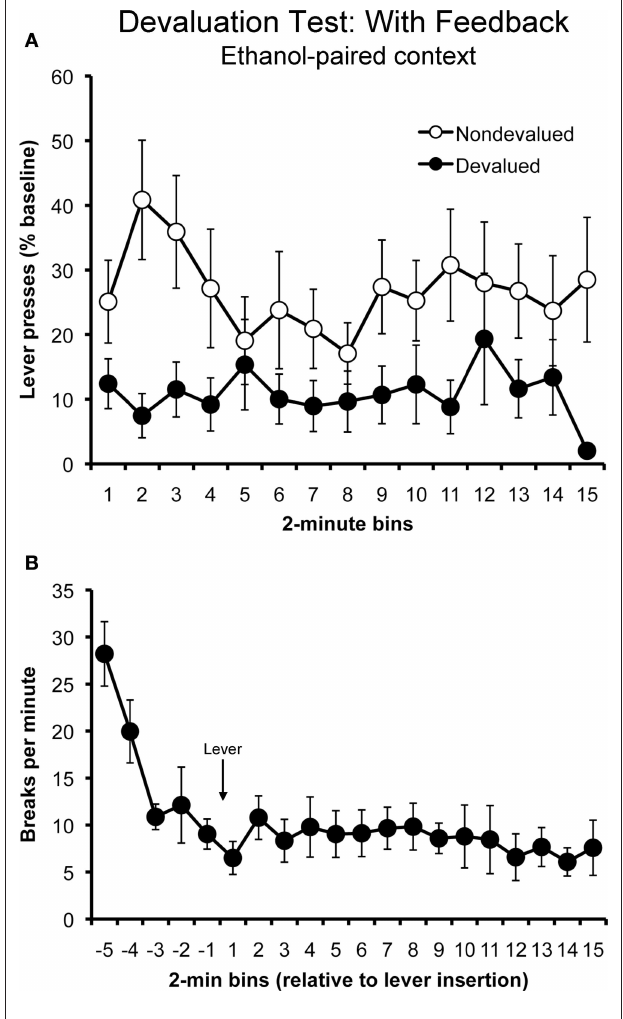
FIgure 3 | Sensitivity to outcome devaluation in the ethanol-paired context in the rewarded test (i.e., with response-contingent feedback) (experiment 1) . Mean rate of lever pressing (percentage of baseline, ± SEM) for the devalued and non-devalued outcomes (A) . Rats displayed a selective suppression in their performance of the action that earned the devalued outcome at test, despite the presence of ethanol-paired cues. Mean locomotor activity (photobeam breaks, ± SEM) observed during the rewarded outcome devaluation test (B)